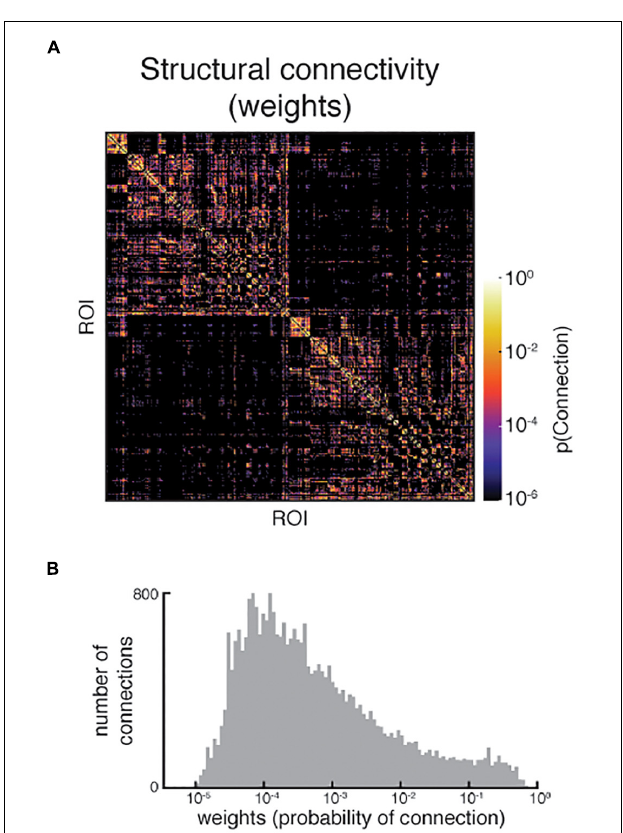
FIGURE 10 | (A) An example structural connectivity matrix of poorer quality. Note the sparsity, especially in the interhemispheric quadrants (top right and bottom left), which was confirmed by (B) the relatively small distribution of non-zero weights in the matrix. Upon further examination, the dMRI registration to T1w was poor, resulting in some tractography seeds and targets being placed in non-brain tissue. Both images shown are reproduced from the QC